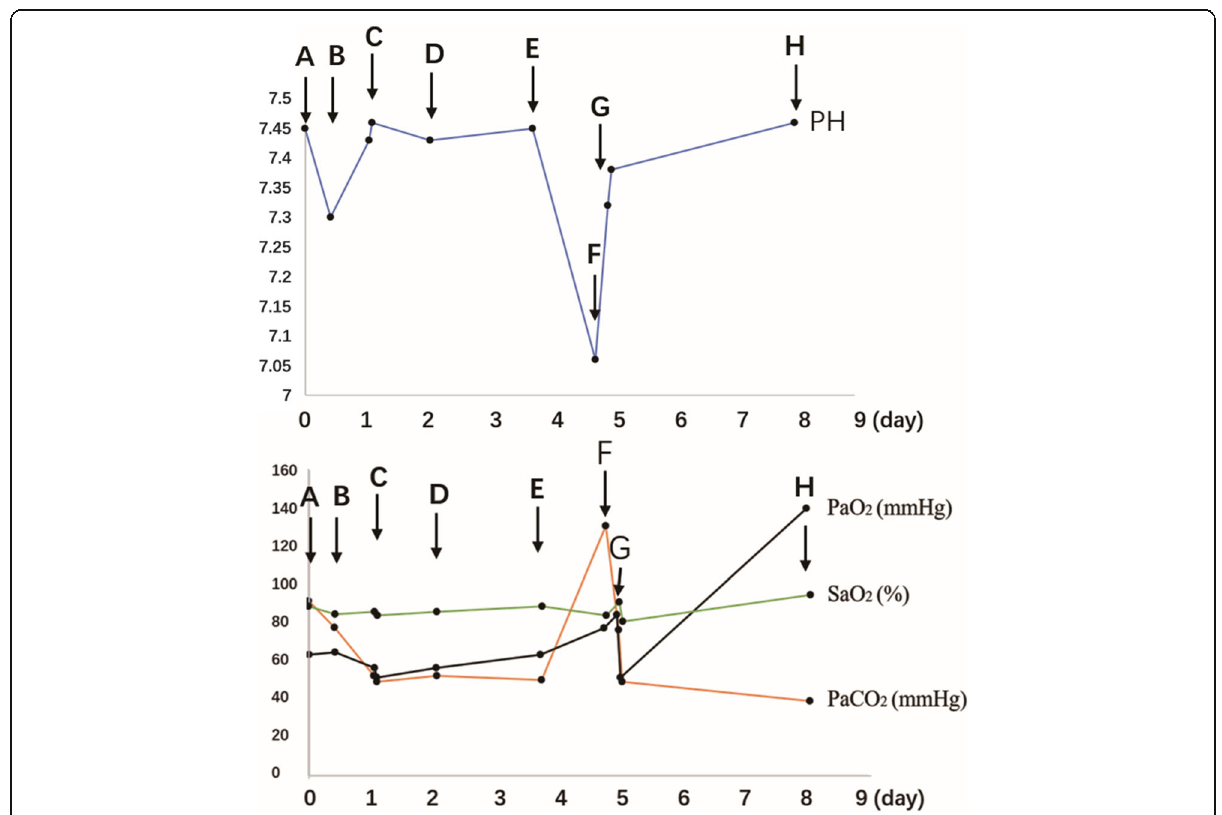
Fig. 1 Changes in PH, PaO 2, and SaO 2 were detected by